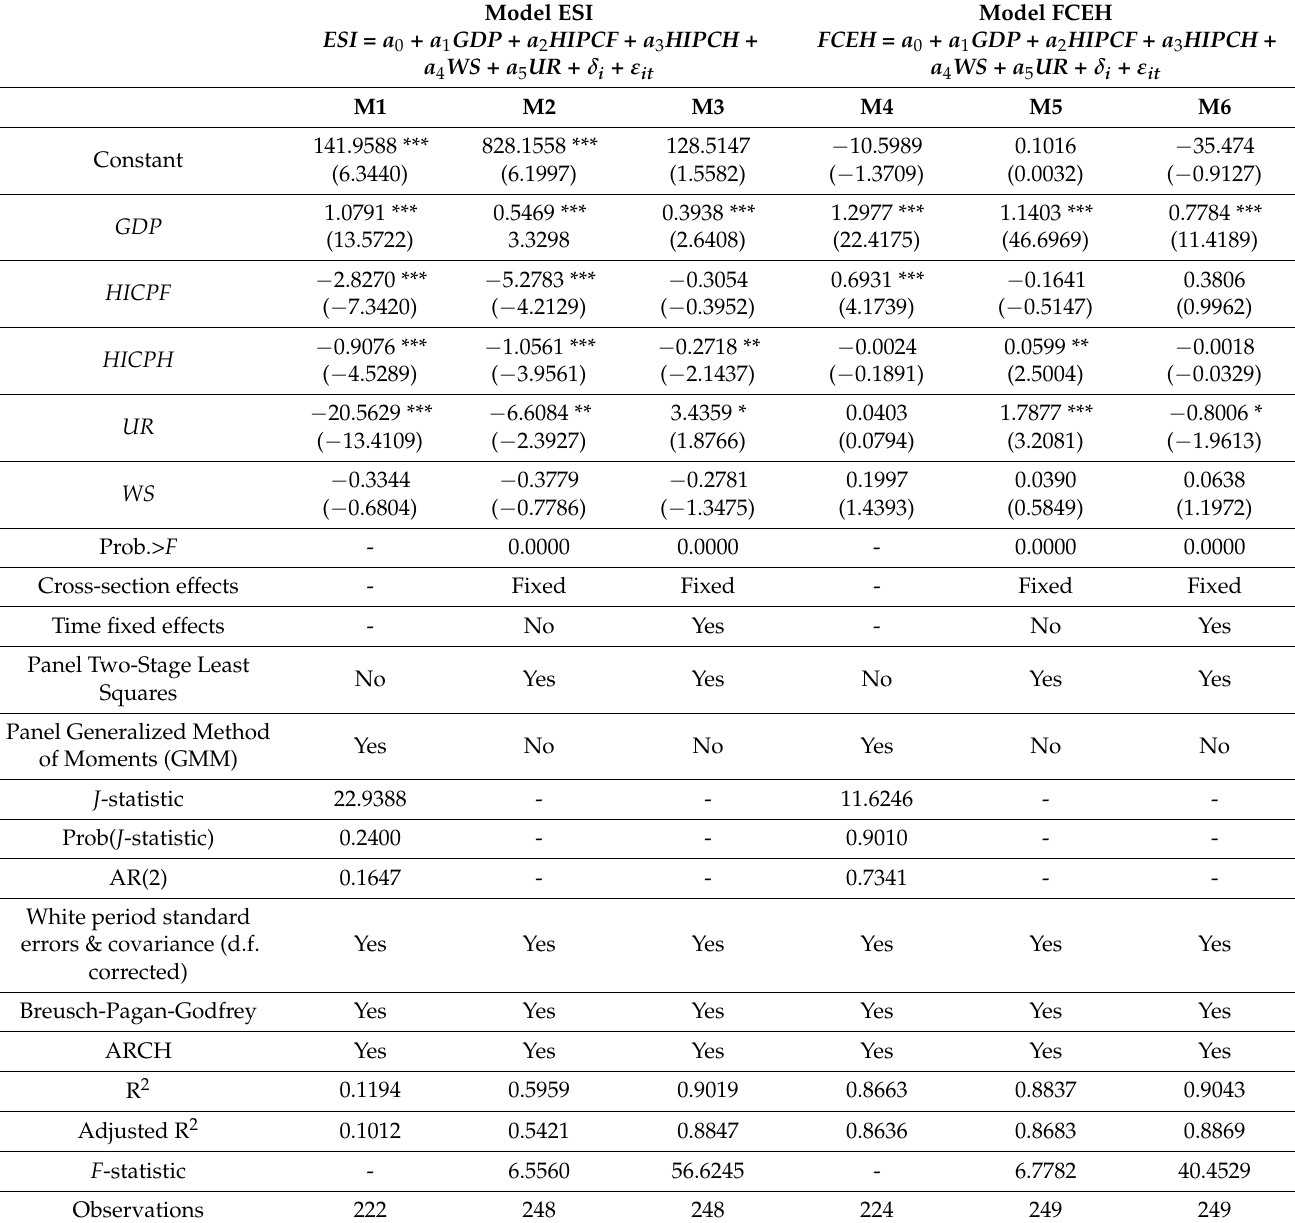
Table 3. Econometric models estimating the relationships between the variables of